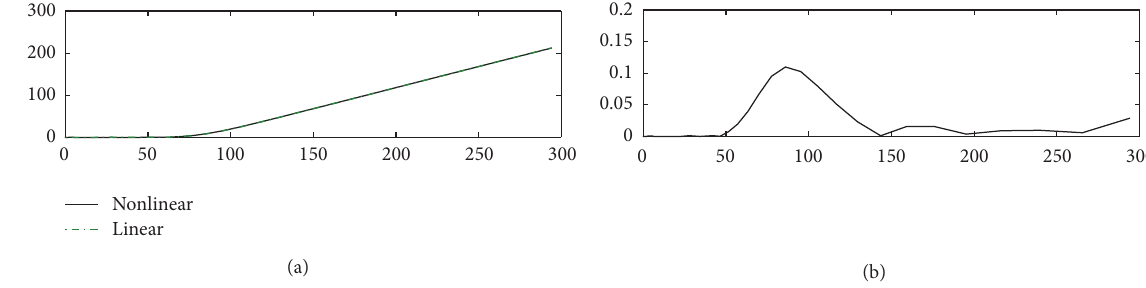
Figure 3: Error of call option price between the linear and nonlinear Black-Scholes